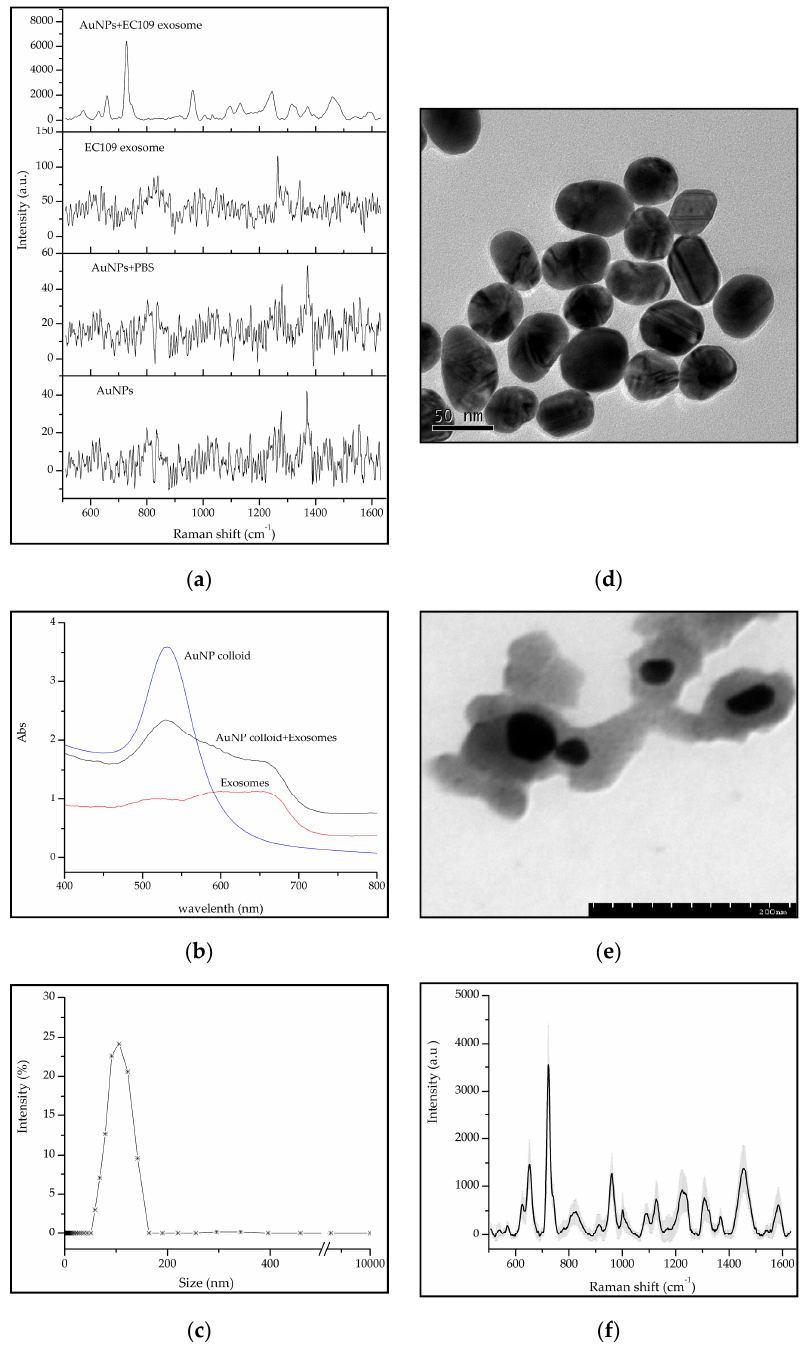
Figure 2. The Raman signals of exosomes were enhanced by Au nanoparticles. ( a ) The SERS and non-SERS spectra of exosomes; ( b ) Plasmon resonance absorption of Au colloid and exosomes; ( c ) The particle size distribution of Au colloid by DLS; ( d ) TEM of AuNPs; ( e ) TEM of gold nanoparticles and exosomes complex; ( f ) Mean SERS spectra (black line) and the standard deviation (gray area) of EC109 cell-derived exosome.